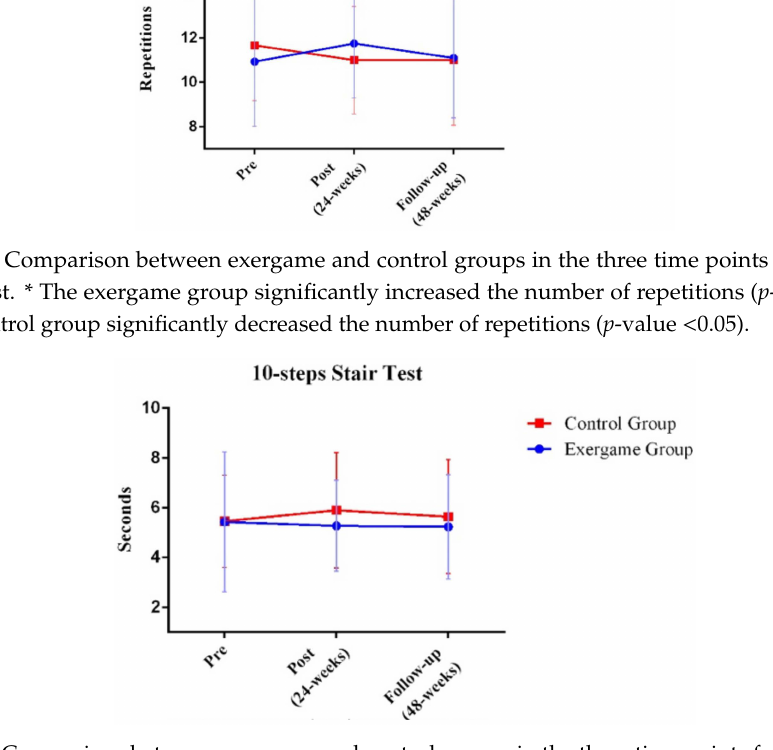
Figure 3. Comparison between exergame and control groups in the three time points for the 10-steps Stair Test. Significant e ff ects were not found ( p -value > 0.05).